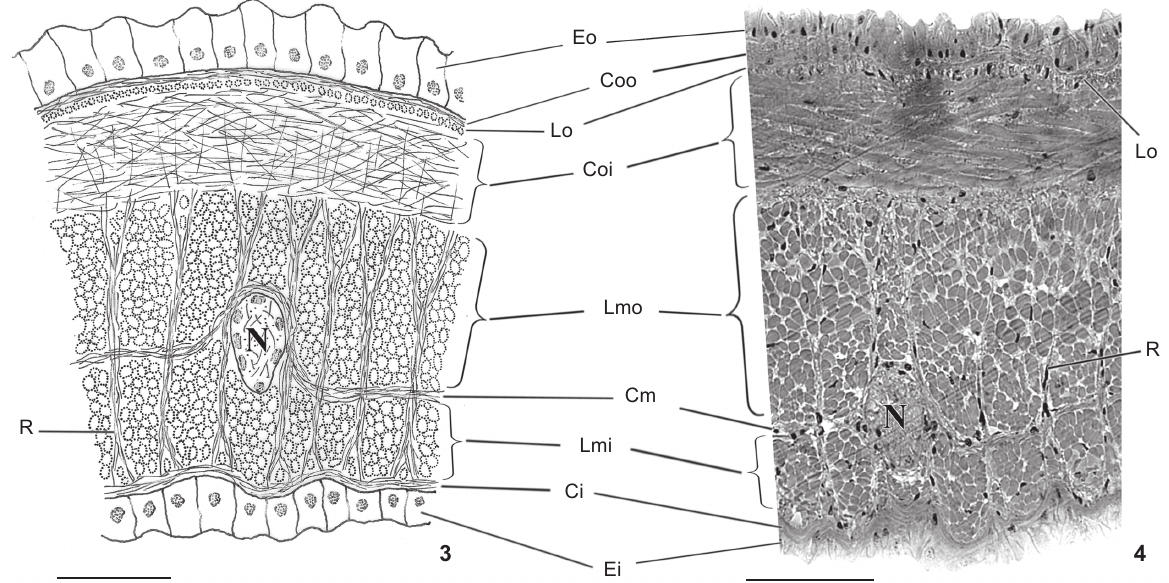
Figures 3-4. Macoma biota . Diagrammatic representation (3) of the cross section (4) of the exhalant siphon. (Ci) Inner circular layer, (Cm) median circular layer, (Coi and Coo) inner and outer parts of the outer circular layer, (Ei) inner epithelium, (Eo) outer epithelium, (Lmi and Lmo) inner and outer parts of the median longitudinal layer, (Lo) outer longitudinal layer, (N) nerve cord, (R) radial fibers. Scale bars: 10